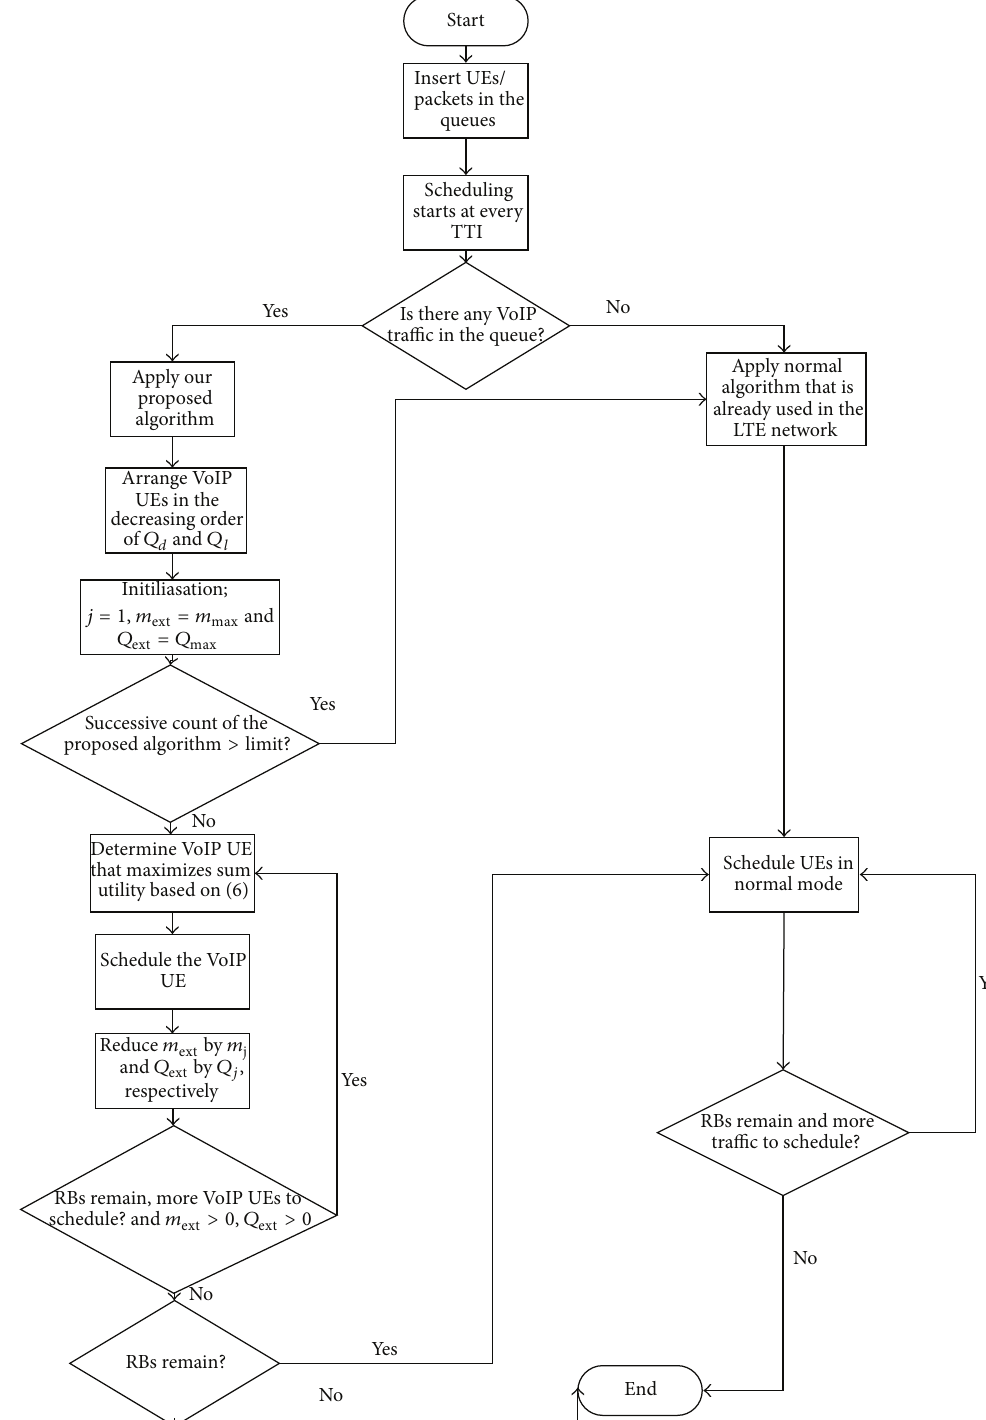
Figure 2: Algorithm flow